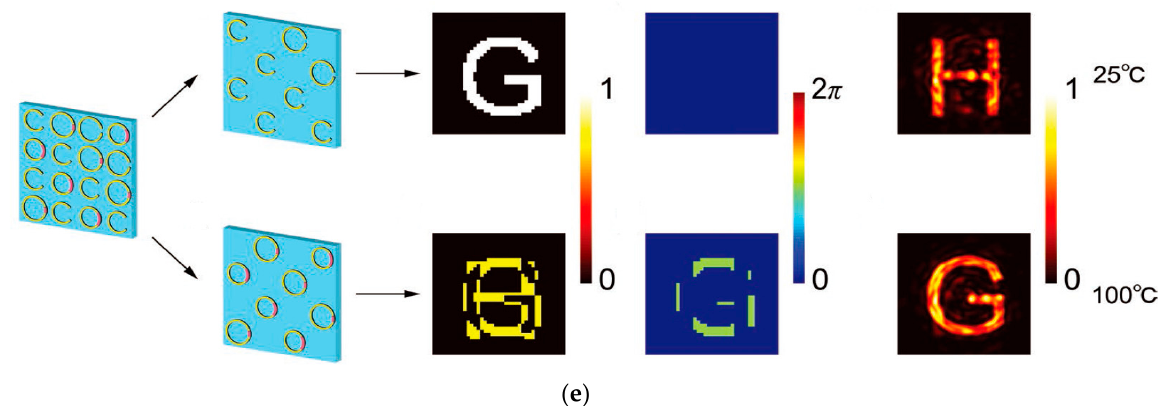
Figure 8. Dynamic metasurfaces with VO 2 . ( a ) A rewritable canvas with laser − controlled metasurfaces [139]. The resistance of VO 2 sweeps as the temperature changes. Copyright John Wiley and Sons, 2018. ( b ) Thermally controlled chiral metasurfaces [143]. ( c ) Electrically controlled nanoantenna arrays with wire grid [145]. ( d ) Optically controlled metasurfaces for amplitude and frequency manipulation [146]. ( e ) Active SRR metasurfaces integrated with VO 2 for holography imaging [153]. Copyright John Wiley and Sons, 2019.